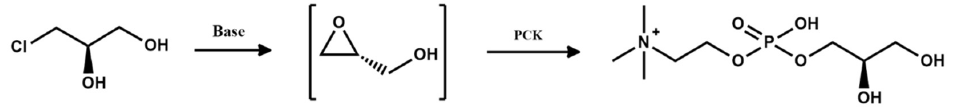
tra of each reaction entry in Table, Figure S17, HPLC chromatogram of crude product, Figure S18, HPLC chromatogram of pure choline alfoscerate, Figure S19, HRMS data of pure choline alfoscerate, Tables S1–S6, summary of each reaction conditions and